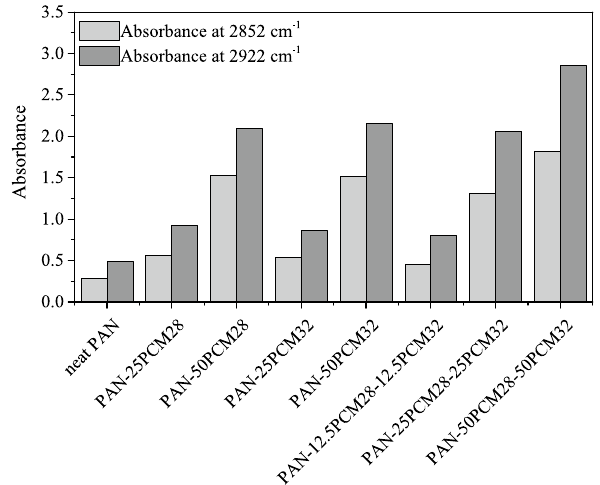
Figure 4. Variations of absorbance values of peaks at 2852 and 2922 cm −1 .